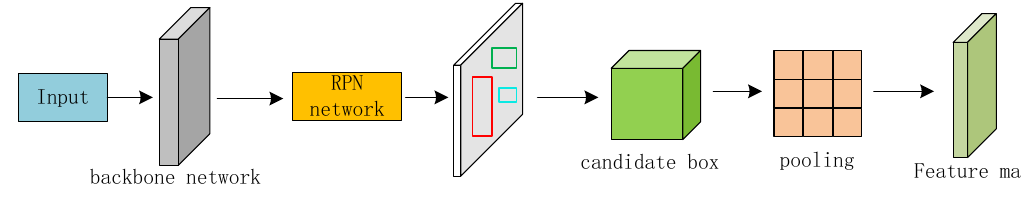
Figure 4. ROI pooling principle.